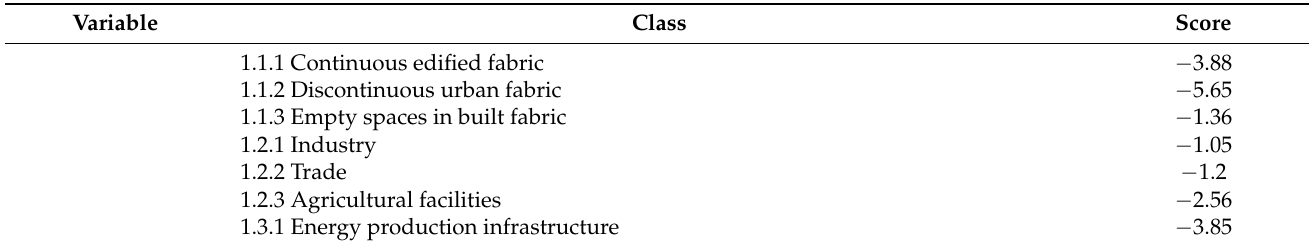
Table 10. Wildfire favorability scores generated by the developed script with training area 3, 6 years of occurrences and different individual environmental